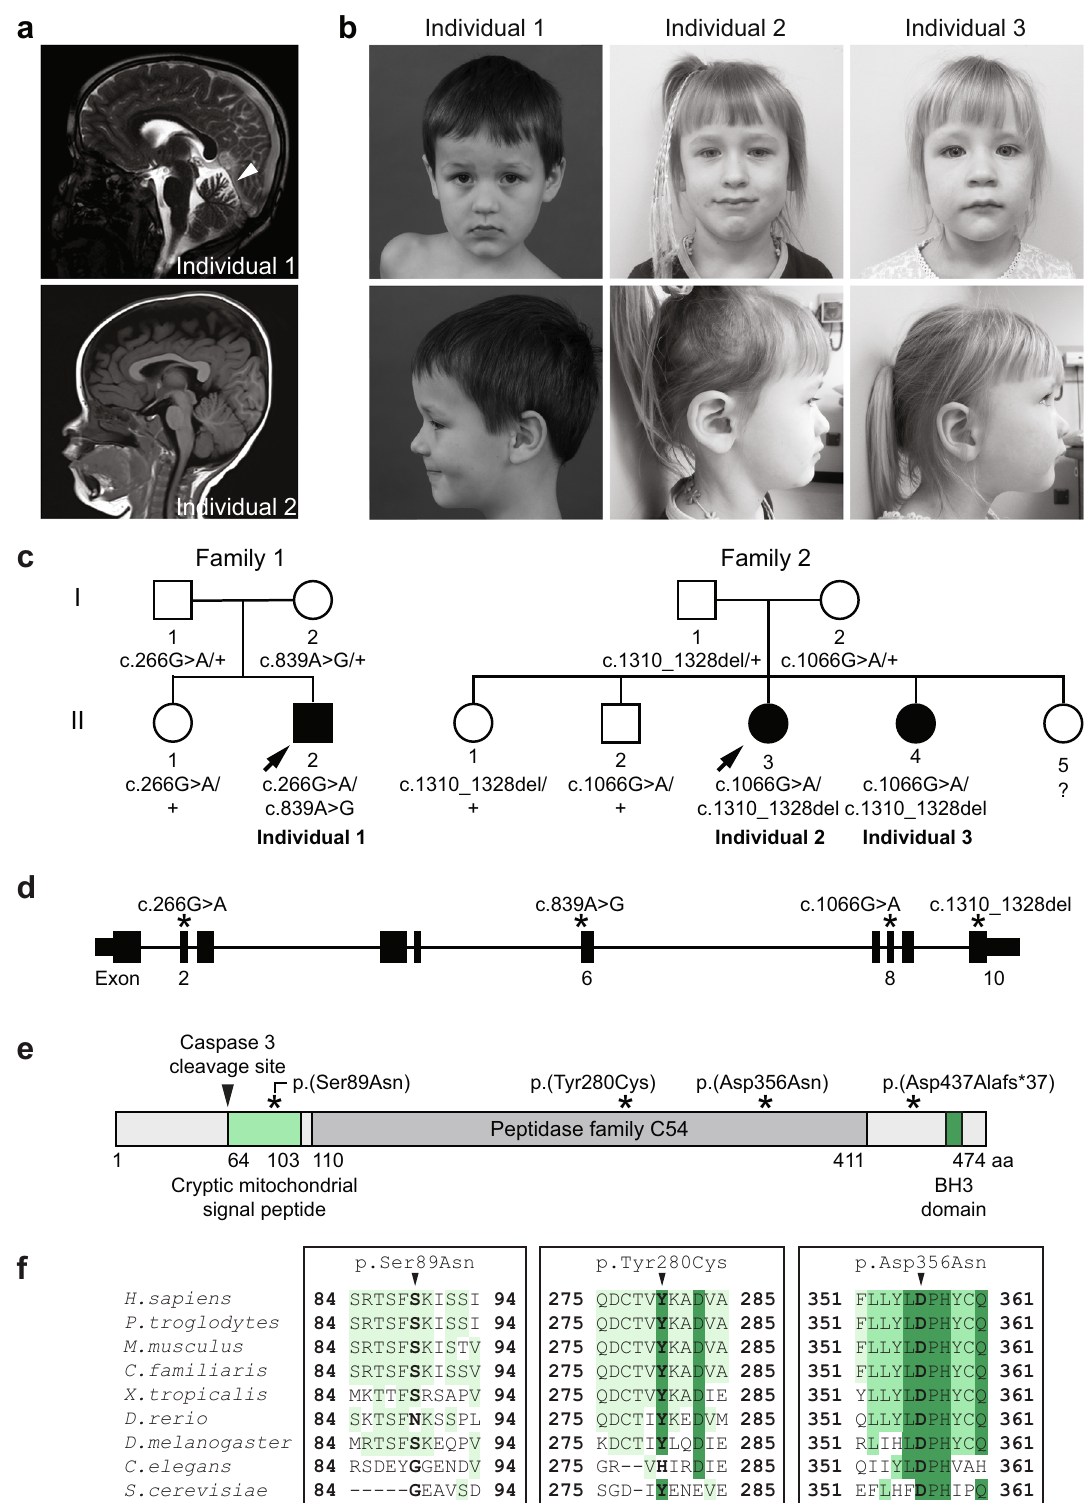
identi fi ed missense ATG4D variants ranged from 0.00040% to 0.061% with no homozygotes recorded; CADD phred scores were consistent with deleterious sequence variation (Supplementary Table 1). Furthermore, these variants affect conserved amino acid residues (Fig. 1f) and are predicted to be damaging by